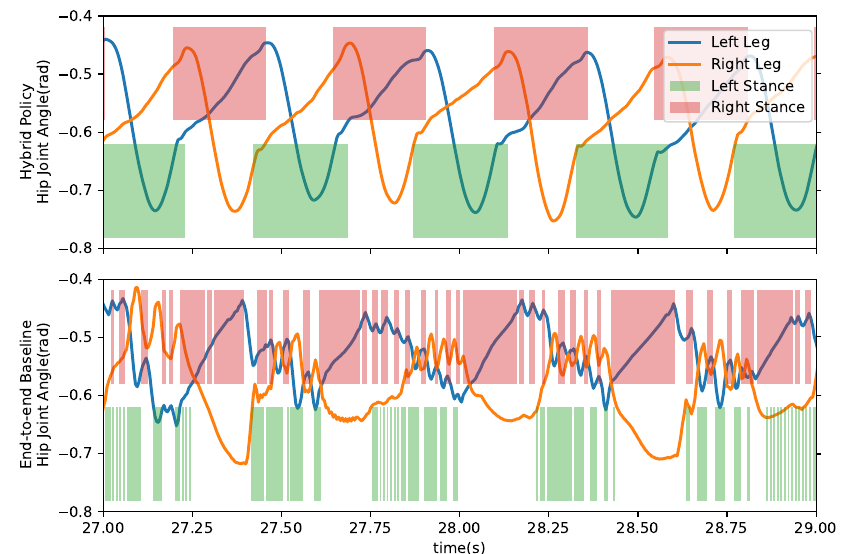
Figure 8. Plot of hip joint position and contact time series while walking. Colored area refers to the foot is having contact with ground at the time. Upper sub-plot’s data is generated by proposed hybrid method, and lower sub-plot plots end-to-end baseline data. Both trajectories are recorded from the test episode described in Figure